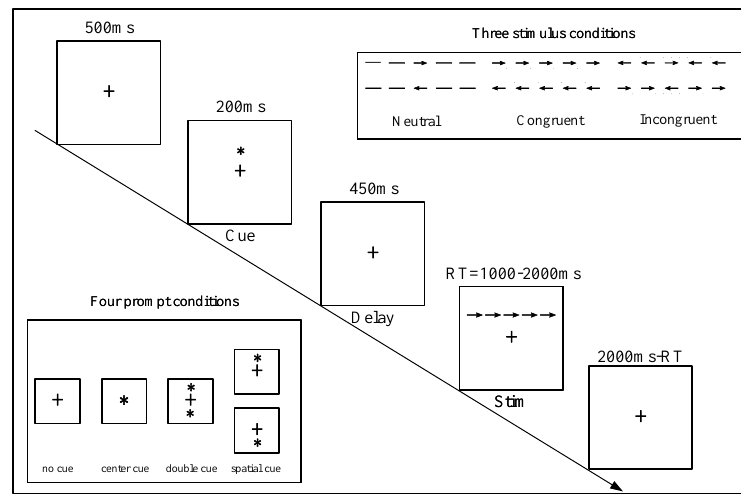
Figure 4. Task parameters and timing for the